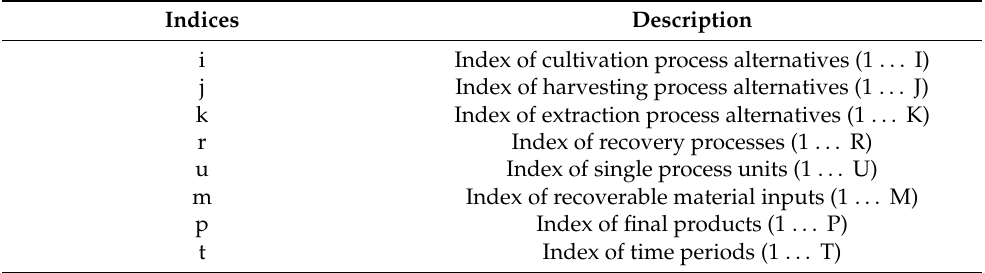
Table A8. Model indices.